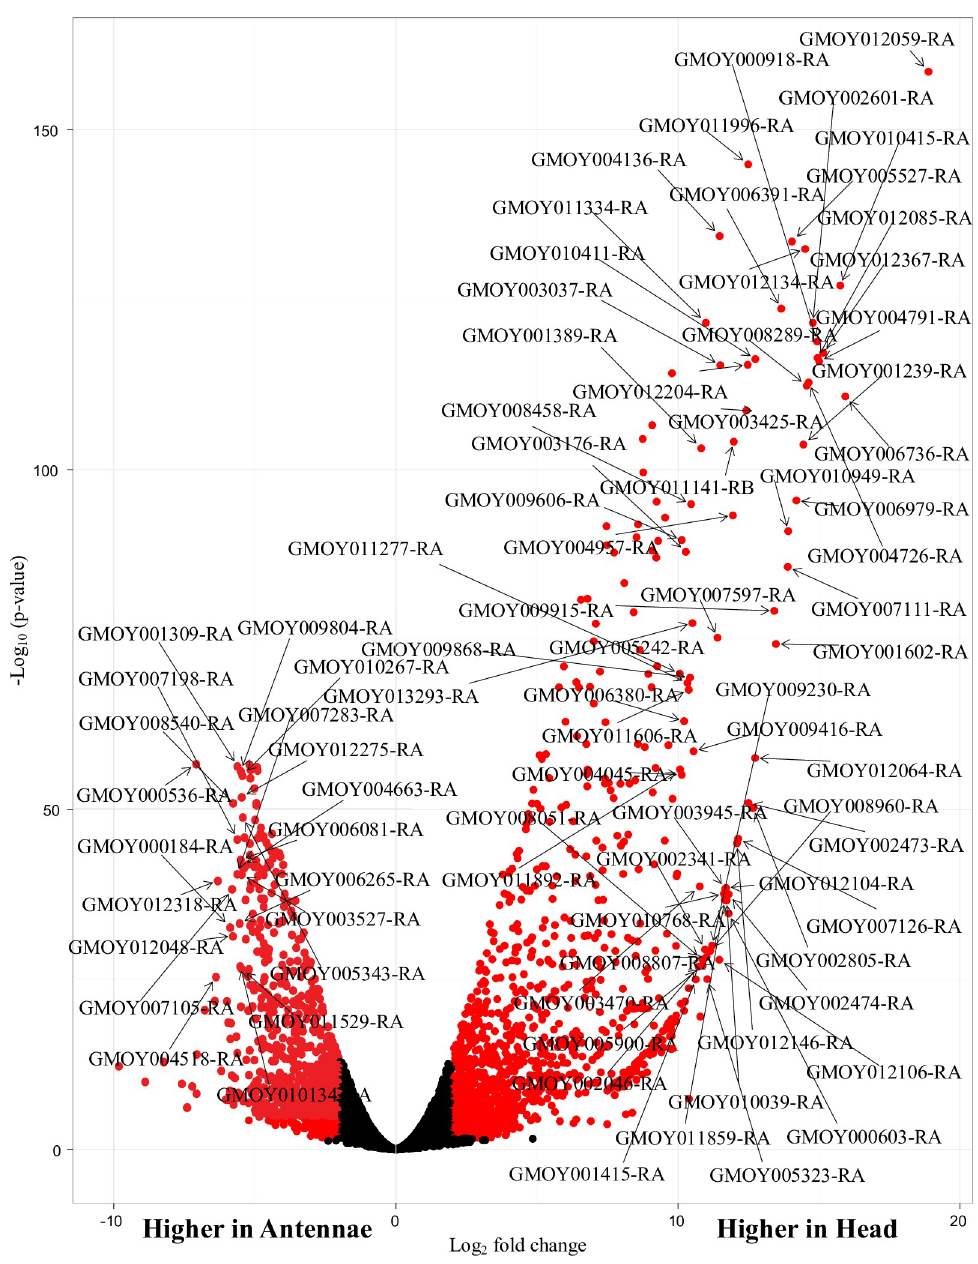
Fig 4. Volcano plot showing abundantly and significantly expressed transcripts between the male G . m . morsitans head and antennae transcriptomes. Dots indicate points-of-interest that display fold-changes (x axis) and statistical significance (-log10 of p value, y axis) in transcripts between the head and antennae transcriptomes. Red dots indicate transcripts with fold-changes of two or more (log 2 � 1) and False Detection Rate (FDR) corrected p values of less than 0.05 and are indicate transcripts with significant changes between the transcriptomes. Black dots represent transcripts with non-significant changes between the transcriptomes. associated with detection of pheromones appears to be conserved across all the tsetse fly spe- cies, which in concert with similarly conserved Or67d and Orco orthologs, are functionally associated with detection of lipid-derived pheromones [98,99]. Other conserved pheromone responsive orthologs, include male-specific pheromone 11-cis-vaccenyl acetate (cVA)